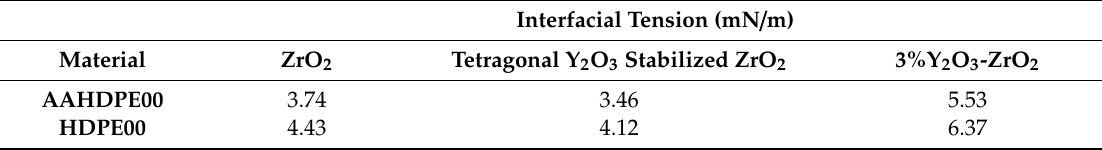
Table 5. Calculated interfacial tension between the two types of polymers and di ff erent zirconia types.